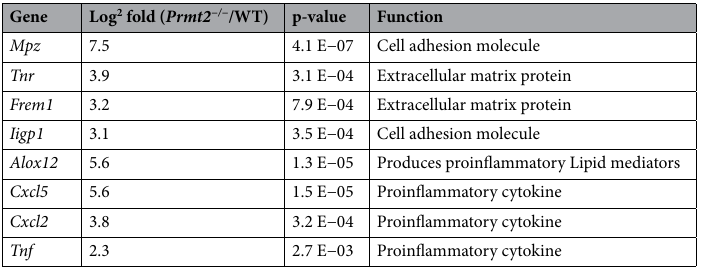
Table 1. Genes upregulated in Prmt2 −/− compared to WT regressing plaque CD68+ cells associated with cell adhesion and inflammation. Expression change from RNA-seq